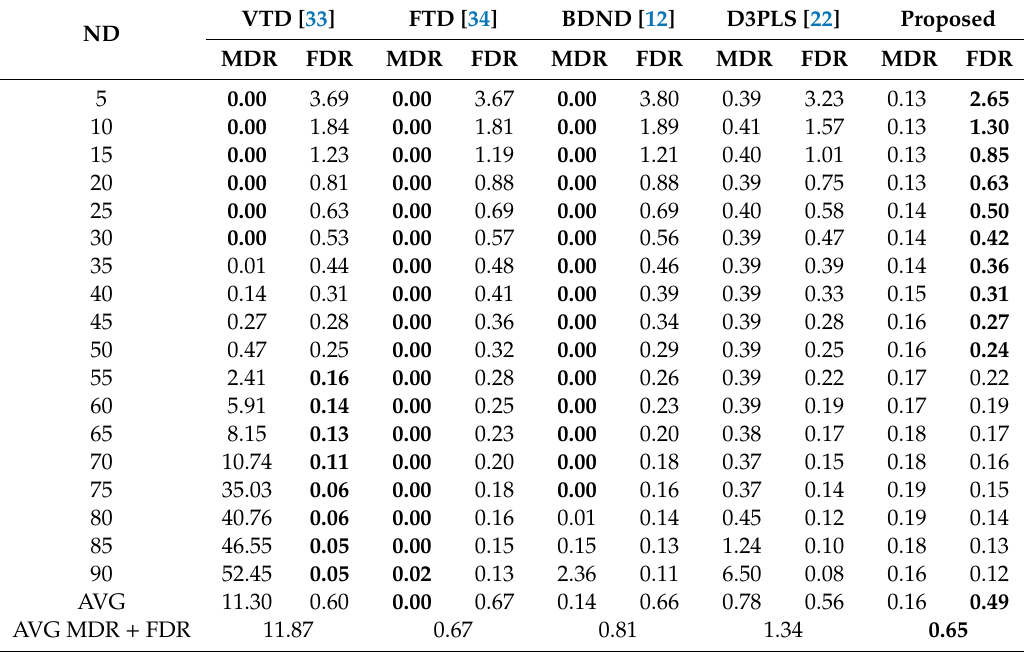
Table 3. The results of the noise detection stage.